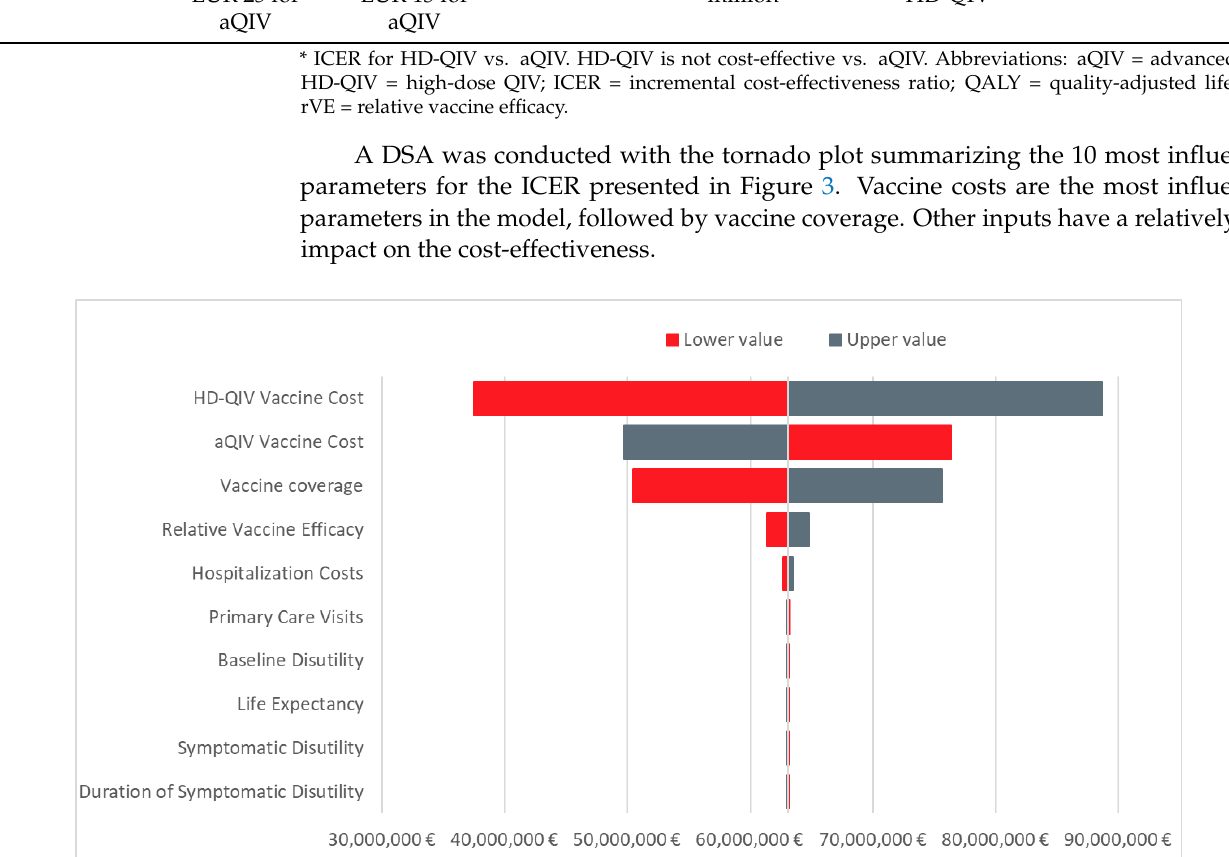
Figure 4. Cost-effectiveness plane for aQIV vs. HD-QIV. Abbreviation: QALY = quality-adjusted life year. Orange line represents the willingness-to-pay threshold in Spain of EUR 25,000 per QALY [55,56]. 4. Conclusions Cost-effectiveness analysis is frequently used to assess the value of new vaccines, with a number of influenza models being published recently for Spain [10,23,24,57]. They enable healthcare providers to make informed decision around optimum vaccination strategies based on best available evidence. In the Spanish setting, aQIV has yet to be com- pared the HD-QIV in the population aged 65+. This analysis demonstrates that, largely driven by the economic benefits associated with vaccinating a large population with a less expensive vaccine with comparable effectiveness, aQIV is cost-saving compared to HD- QIV from both a direct medical payer and societal perspective. The results from Spain